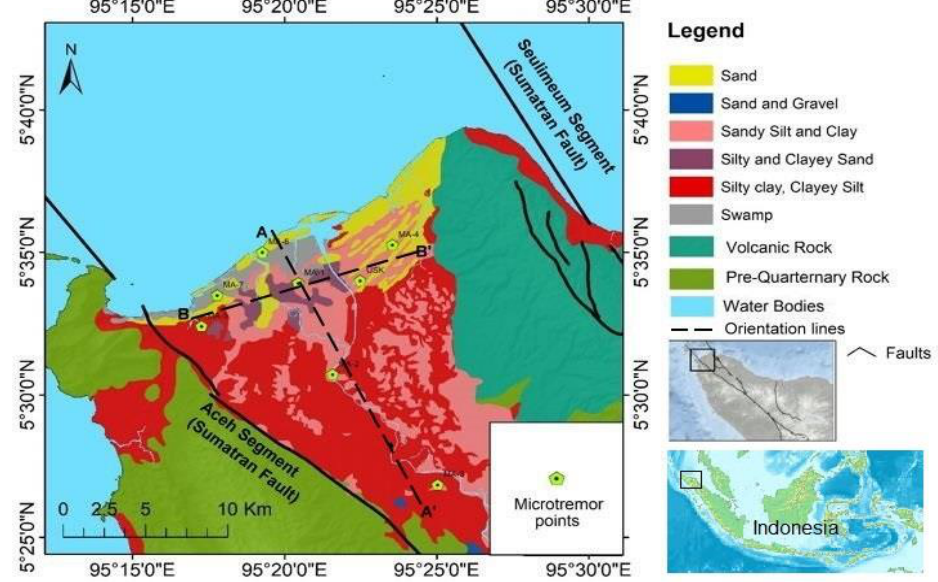
Figure 1. Engineering geology map of the Krueng Aceh Basin and its surrounding mountain and microtremor points; modified from [14].